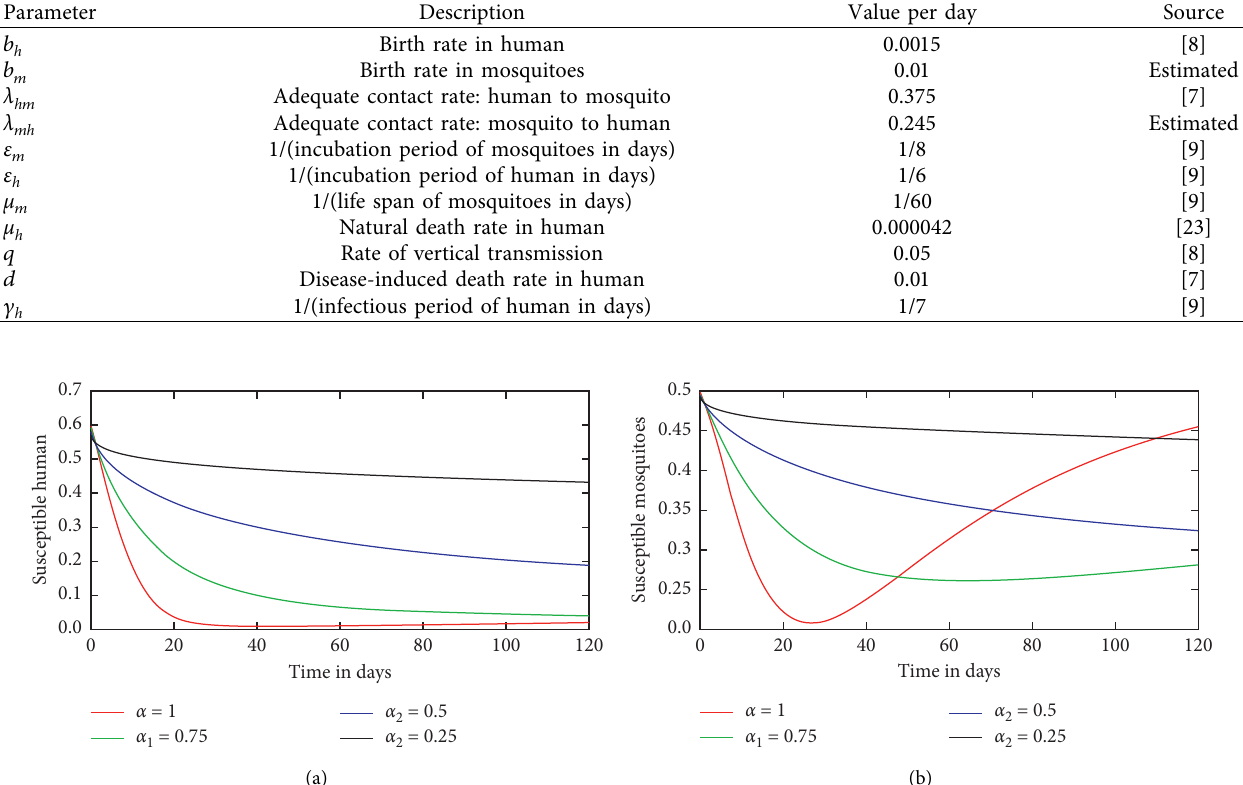
Figure 2: Variations of susceptible population at α � 1, 0.75, 0.50, and 0.25: (a) susceptible human; (b) susceptible mosquitoes.